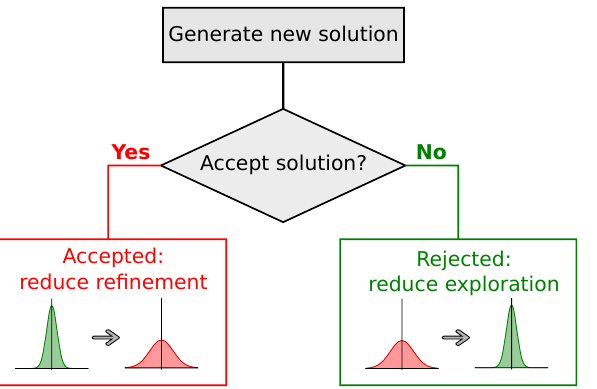
Figure 2. SA provides a feedback to the crystallization factor associated with the modified variable. If the solution is accepted, the crystallization factor is reduced (positive feedback). If the solution is rejected, the crystallization factor is increased (negative